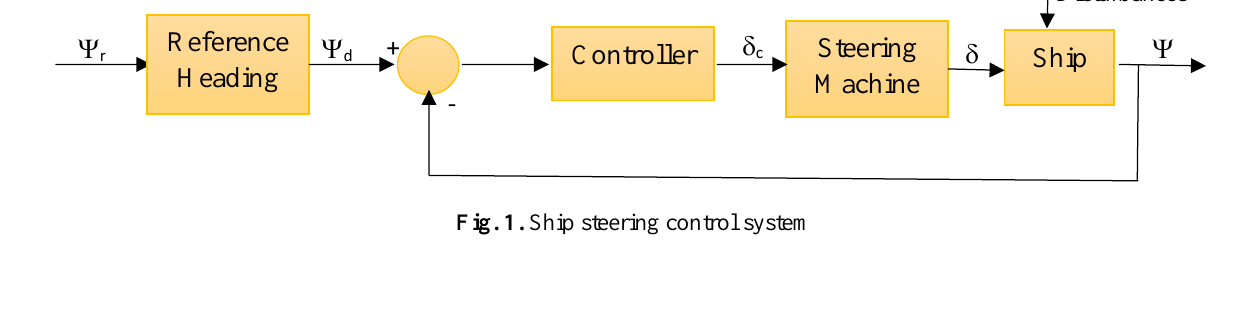
Fig. 1. Ship steering control system